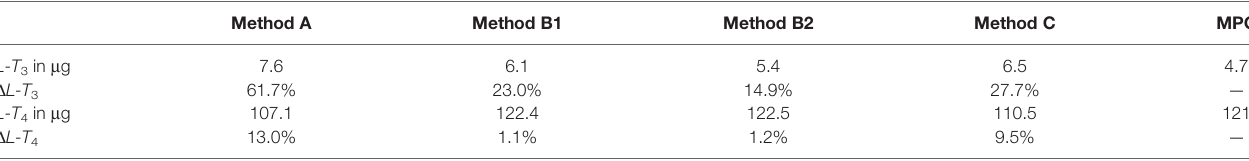
TABLE 2 | Recommended dosages regarding an L - T 3 / L - T 4 combined therapy based on a prior treatment with an L - T 4 monotherapy (here with 130 μg of L - T 4 ) and the four different formulas given in